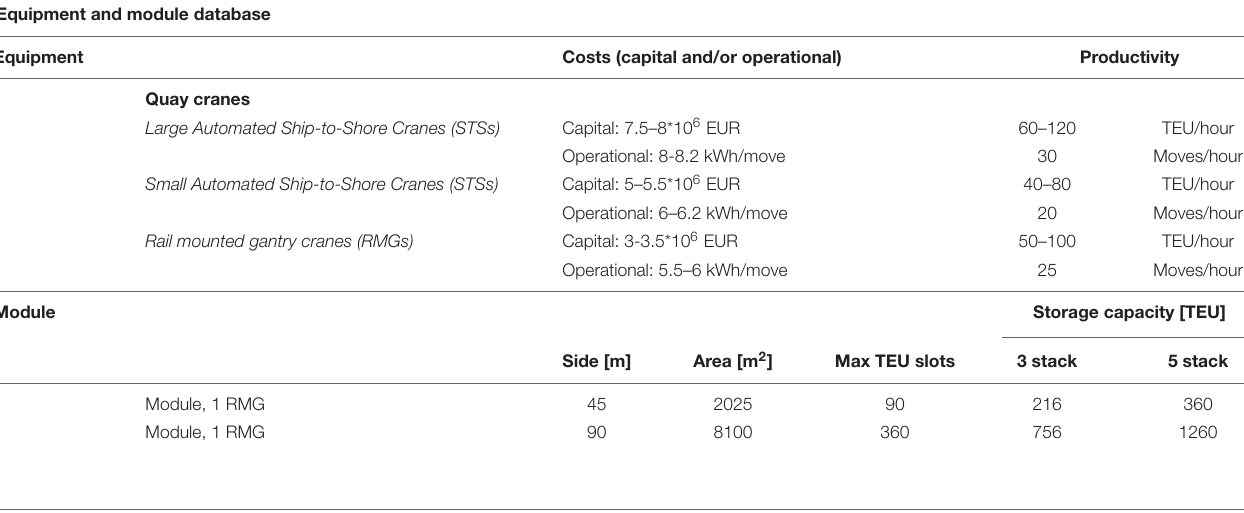
TABLE 6 | Equipment and module